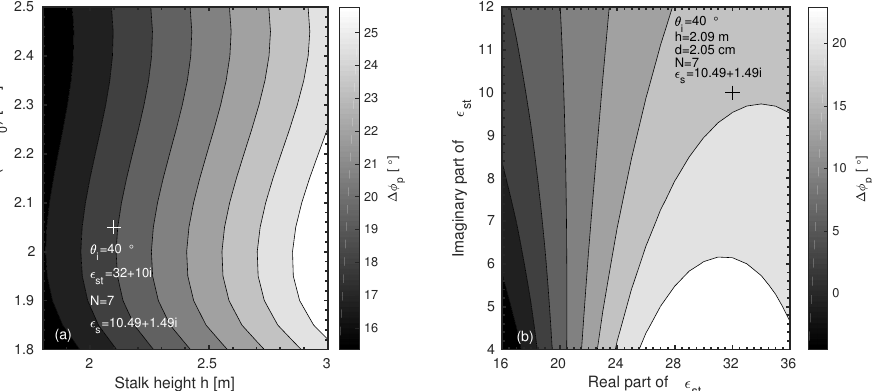
Figure 2. Sensitivity analysis of model parameters. ( a ) Sensitivity of the propagation term on stalk height and diameter 2 a 0 . The ‘+’-mark indicates the average values for the dataset. ( b ) Sensitivity of propagation term on real ε (cid:48) st and imaginary ε (cid:48)(cid:48) st parts of ε st .